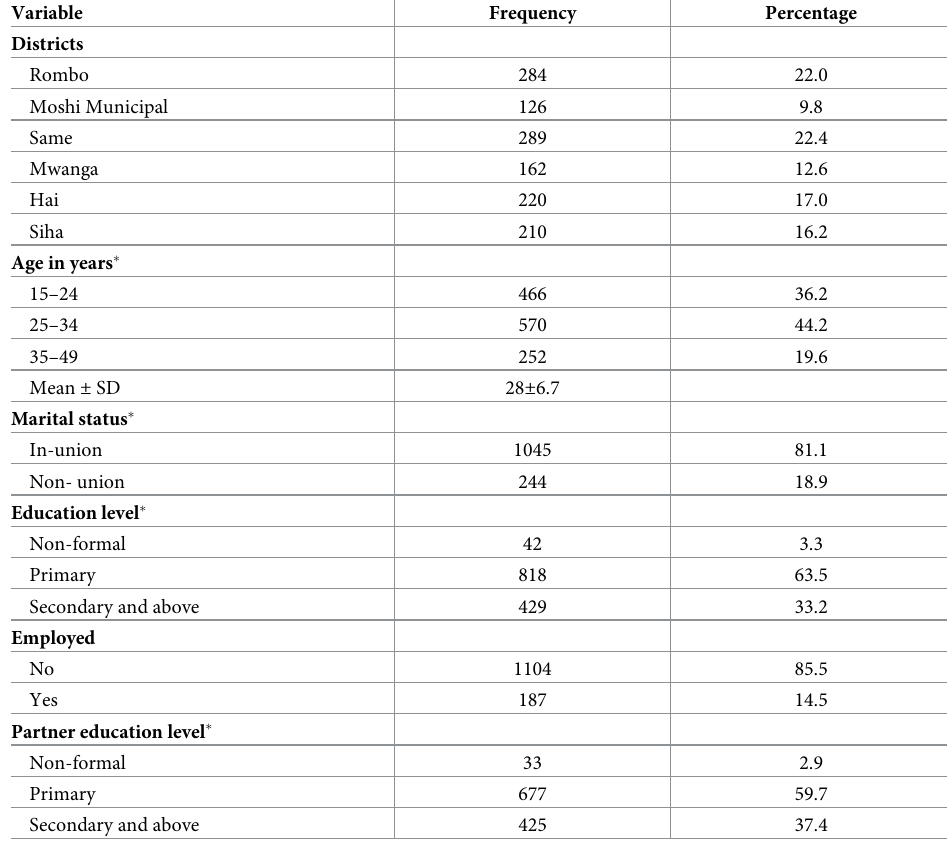
Table 1. Background characteristics of the mother (N =